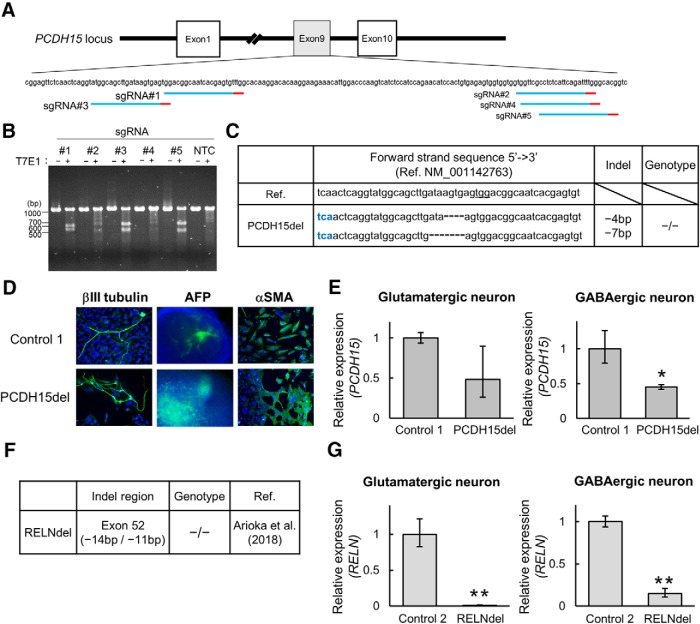
Generation of isogenic PCDH15 deletion iPSCs by targeted genome editing. A, The target sites of CRISPR-sgRNAs in exon 9 of the PCDH15 gene (NM_001142763). Red bars represent PAM (protospacer adjacent motif) sequences. B, Analysis of CRISPR-sgRNA activity by the T7E1 assay using HEK293FT. NTC, No transfection. Among the constructed sgRNAs, sgRNA#3 showed the strongest cleavage activity. C, Indel pattern of the isogenic line using CRISPR-sgRNA#3. Blue letters represent stop codon. D, Representative images of immunocytochemical analysis for in vitro three-germ layer differentiation. Blue indicates Ho and green indicates the pluripotent marker (βIII-tubulin, αSMA, and AFP). Scale bar, 100 μm. E, Relative gene expression levels of PCDH15 (primer set2) in glutamatergic or GABAergic neurons on day 28 (n = 3 independent experiments; mean ± SD; *p < 0.05, Student’s t test). F, Information of isogenic RELN-deleted iPSCs generated in the previous study (Arioka et al., 2018). G, Relative gene expression levels of RELN in induced glutamatergic or GABAergic neurons on day 28 (n = 3 independent experiments; mean ± SD; **p < 0.01, Student’s t test).